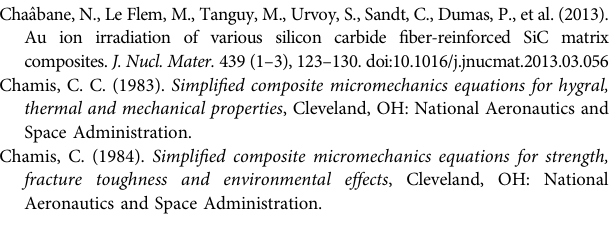
Frontiers in Materials |